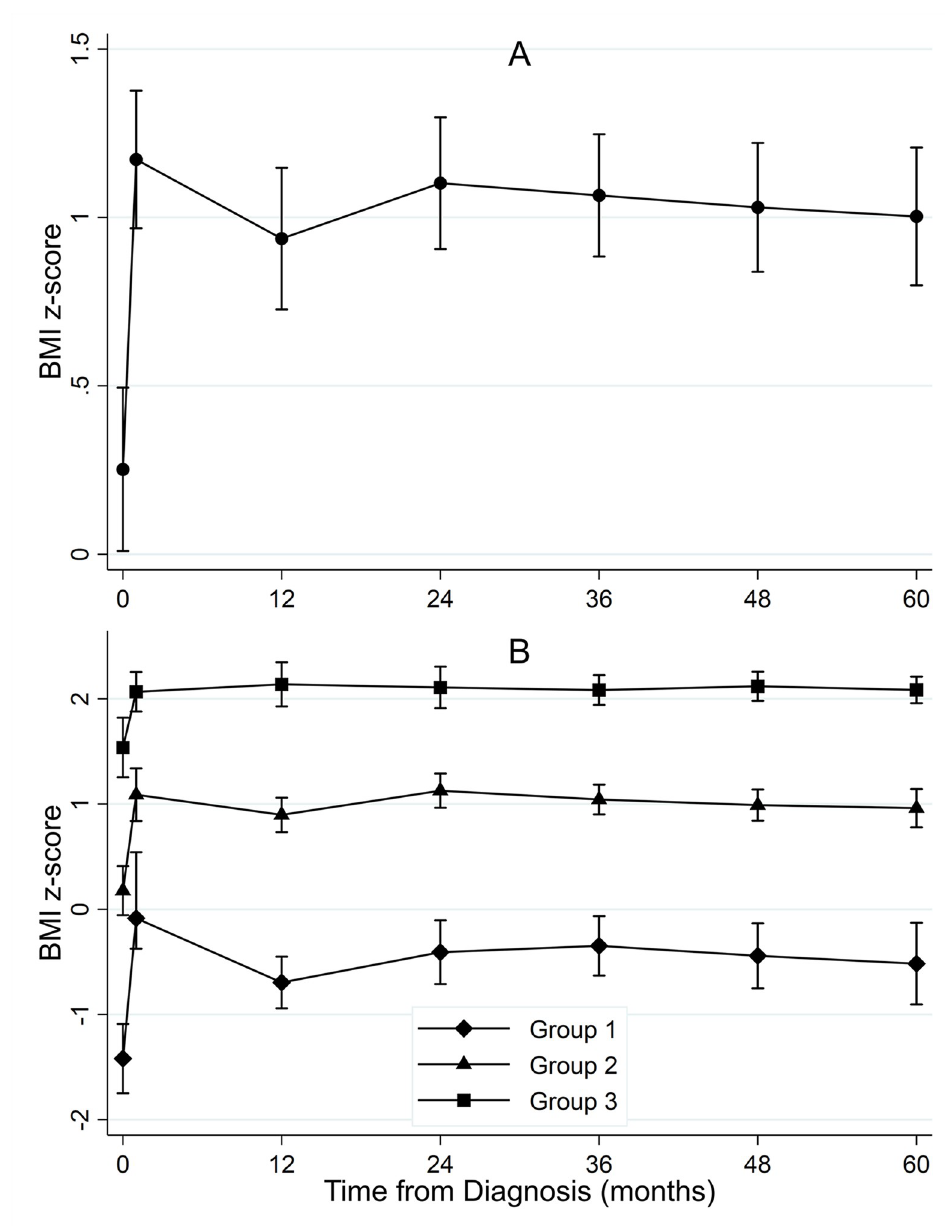
Fig 2. Mean trajectory of BMI z-scores (A) and latent class growth analysis of BMI z-scores (B) between diagnosis and five years post-diagnosis in 121 pediatric ALL patients. In the model evaluating 30 day change in BMI z-scores (Table 2), only BMI z-score at diag- nosis ( β = 0.58, 95% CI: 0.43–0.74) was a statistically significant (p-value = 5.2x10 -11 ) predictor of BMI z-scores at five years post-diagnosis, with higher BMI z-scores at diagnosis associated with higher BMI z-scores five years later. In the second regression model, both BMI z-scores at diagnosis ( β = 0.76, 95% CI: 0.65–0.88) and change in BMI z-scores between diagnosis and one year were statistically significant predictors of BMI z-scores at five years. Each SD increase in BMI z-scores between diagnosis and one year was associated with a 0.63 SD increase (95%